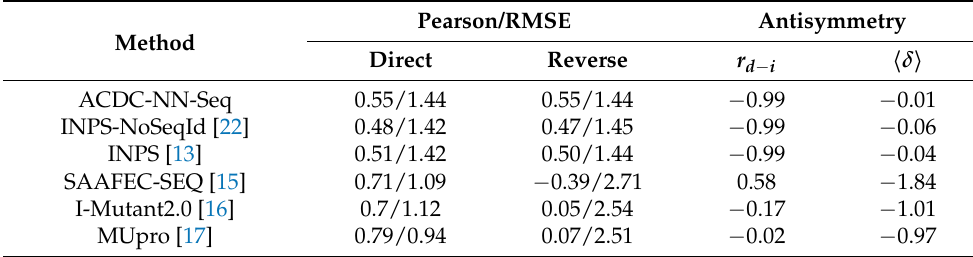
Table 4. Results on Ssym: The performance on both direct and reverse variants was measured in terms of Pearson correlation coefficient (r) and root mean square error (RMSE). The antisymmetry was assessed using the correlation coefficient r d − i (2) and the bias (cid:104) δ (cid:105) (3). RMSE and (cid:104) δ (cid:105) are expressed in kcal/mol. The results of INPS were taken from Montanucci et al. [14] and Fariselli et al. [13]; the results of SAAFEC-SEQ and I-mutant2.0 were obtained using their stand-alone code, those of MUpro were obtained using the webserver available. Only Inps-NoSeqId and ACDN-NN-Seq were trained in cross-validation addressing the sequence identity issue (sequence similarity